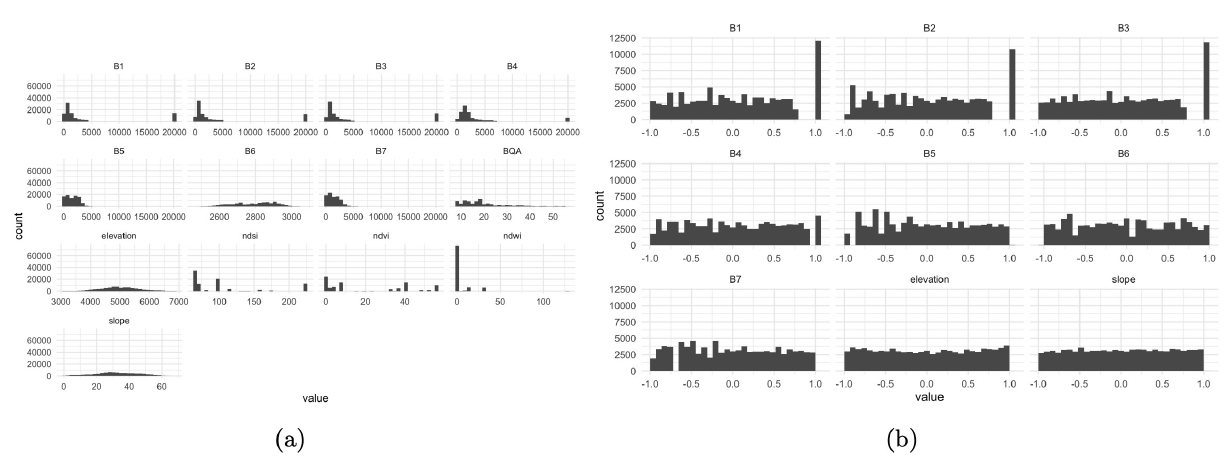
Figure 1. ( a ) Feature histogram before preprocessing. ( b ) Feature histogram after preprocessing. Each feature before preprocessed has significantly different ranges. Each feature is equalized into the same range from − 1 to 1.